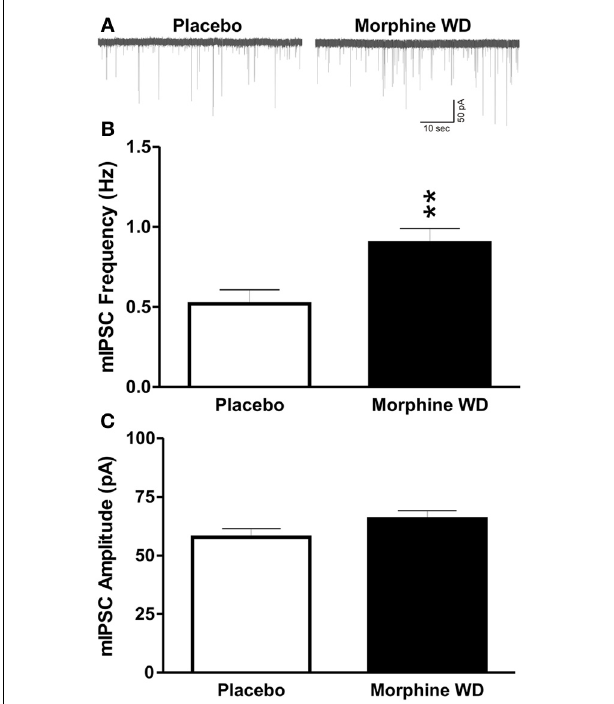
FIGURE 1 | Naloxone-precipitated withdrawal increases GABA release in the CeA from morphine-dependent rats. (A) Representative GABA A mIPSC recordings (in the presence of TTX) from CeA neurons from placebo (left column) and morphine-withdrawn rats (right column), respectively. (B) The mean basal mIPSC frequencies in CeA neurons ( n = 29) from morphine-withdrawn rats were significantly increased ( p < 0 . 01) compared to neurons ( n = 25) from placebo (morphine naïve) rats. (C) There was no significant difference in the mean basal mIPSC amplitude between CeA neurons from placebo and morphine withdrawn rats. The statistical significance ∗∗ p < 0 .